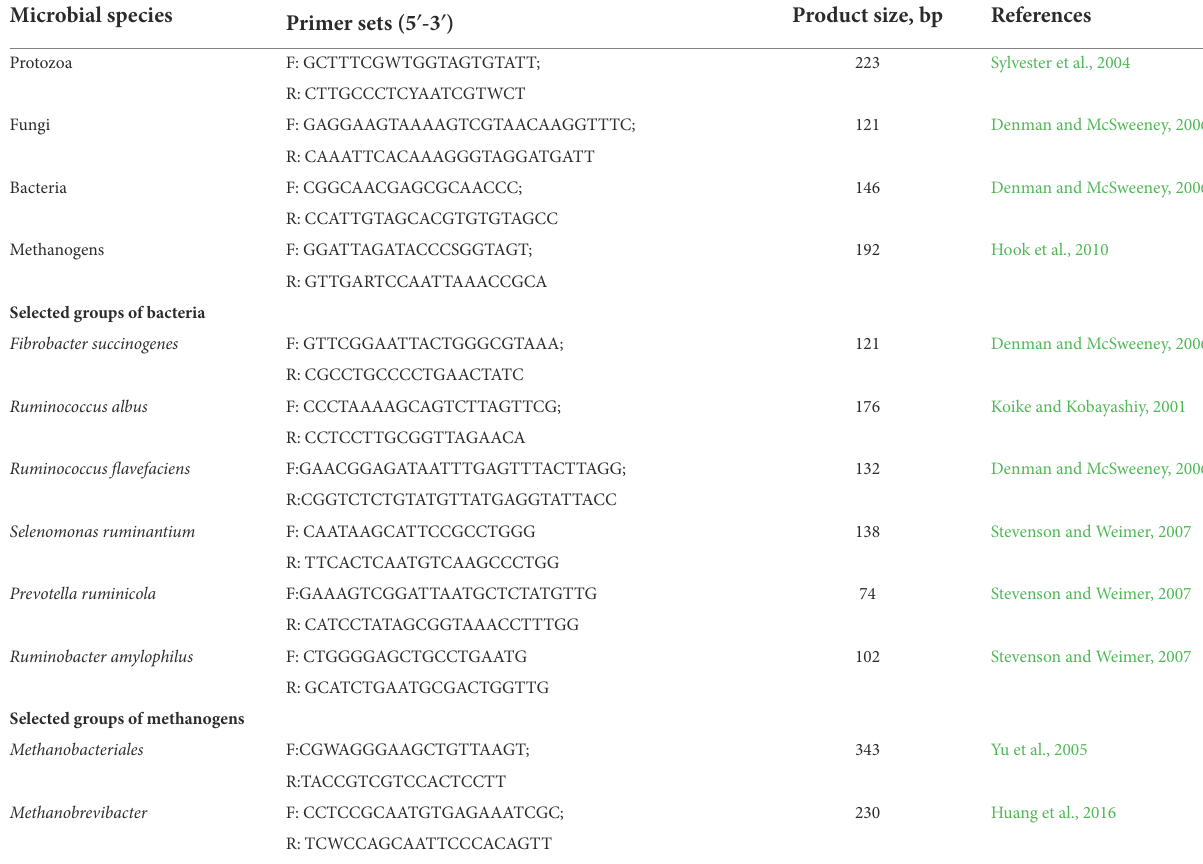
TABLE 1 List of primers used for qPCR